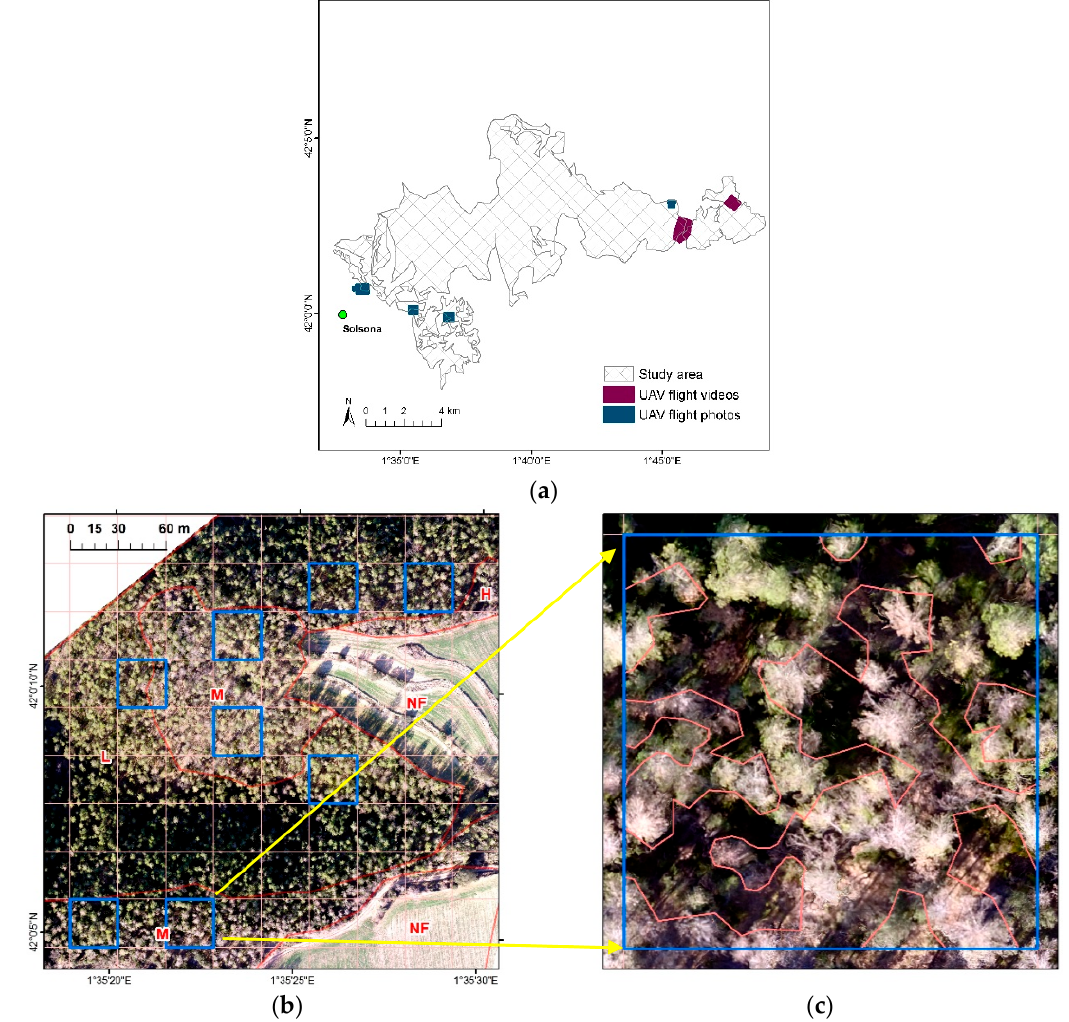
Figure 2. Observed defoliations based on UAV imagery showing: ( a ) the location of UAV sample images captured in photos and videos where sketch map polygons were identified as most severely affected areas in 2016; ( b ) an example of the orthomosaic stratified by land cover and defoliation degree (NF—not forested, L—low, M—medium, H—high) showing selected grid cells of 30 m × 30 m; ( c ) visual interpretation of defoliation in percentage per grid cell (50% in this sample).